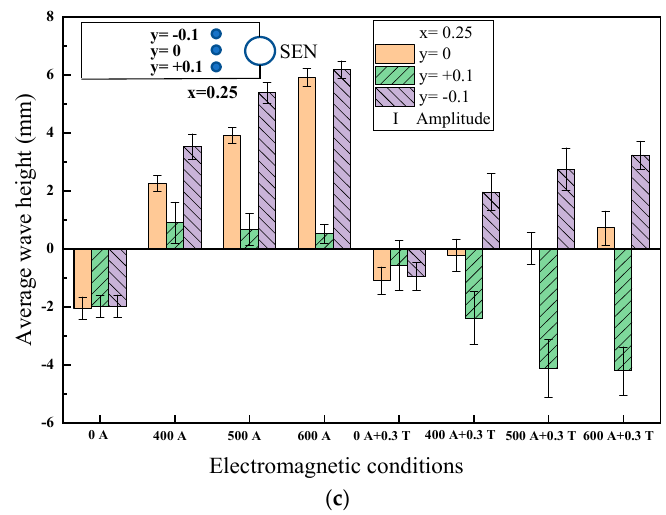
Figure 7. Level fluctuation of the steel/slag interface driven by different electromagnetic conditions. ( a ) x = 0.85 m; ( b ) x = 0.65 m; ( c ) x = 0.25 m.